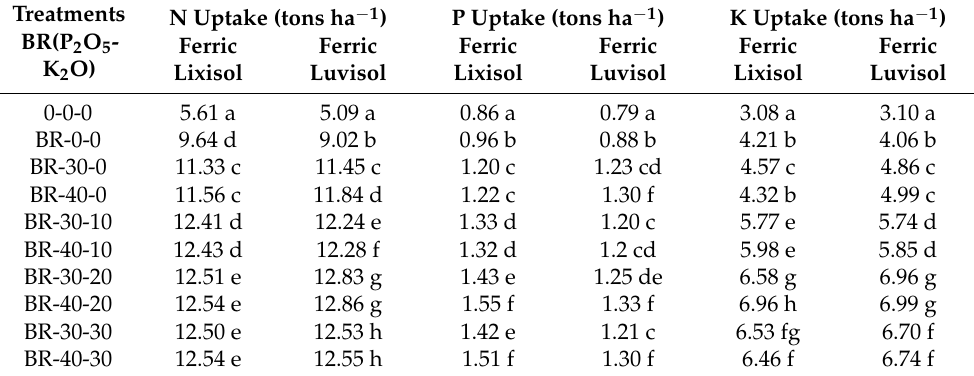
Table 4. Effect of inoculant and fertilizer application on cowpea biomass N, P and K uptake.